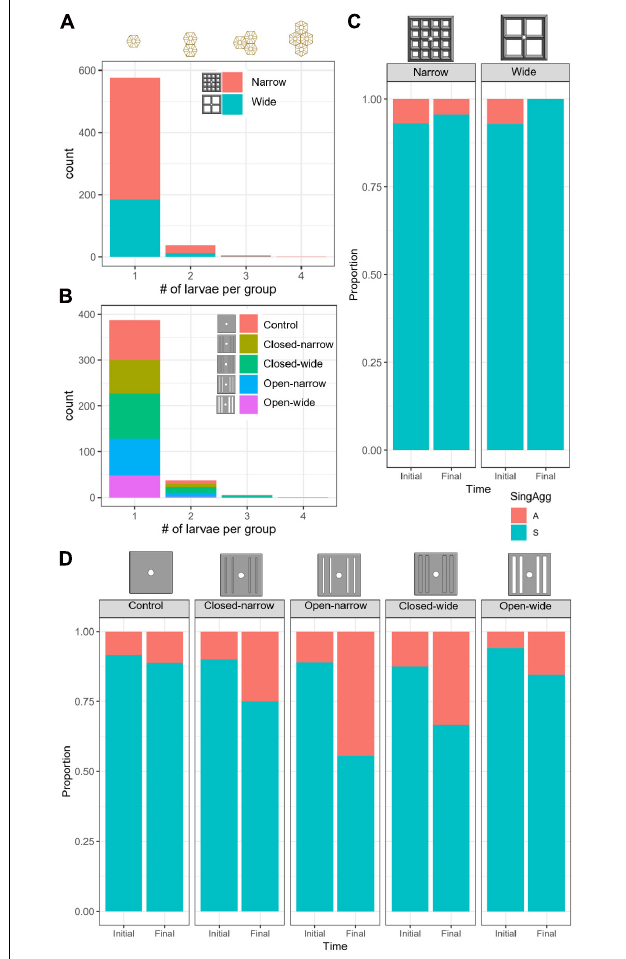
FIGURE 6 | Histograms indicating the distribution of spat that were classified as resulting from 1 (single, “S”), 2, 3, or 4 (aggregated, “A”) larvae for the lattice-grid (A) and grooved-tile (B) devices, by device type (colour). The proportion of spat identified as single spat (“S”) or aggregated spat (“A”) immediately after settlement (Initial) and after approximately 1 year of deployment (Final) on the lattice-grids (C) and the grooved-tiles (D)